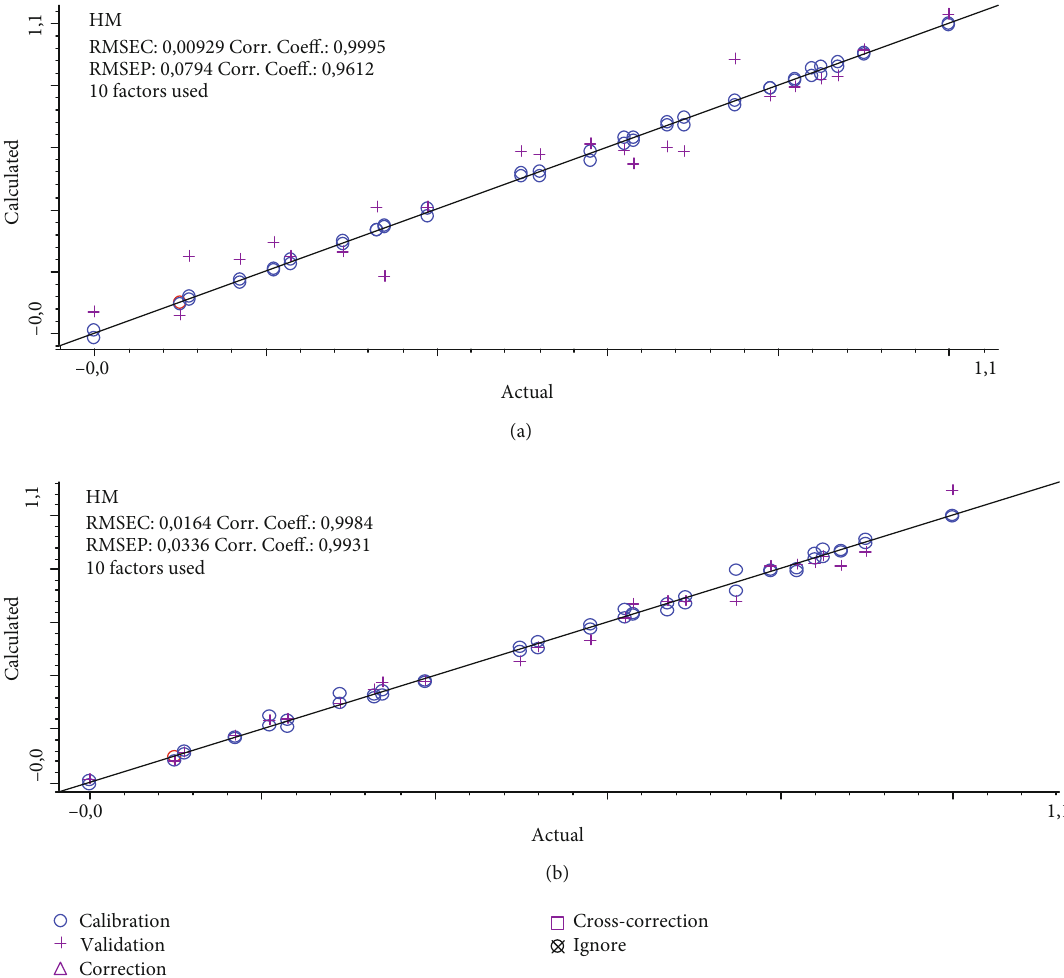
Figure 7: The correlation between the actual value of goat milk (a) and cow milk (b) with FTIR predicted values facilitated by partial least square